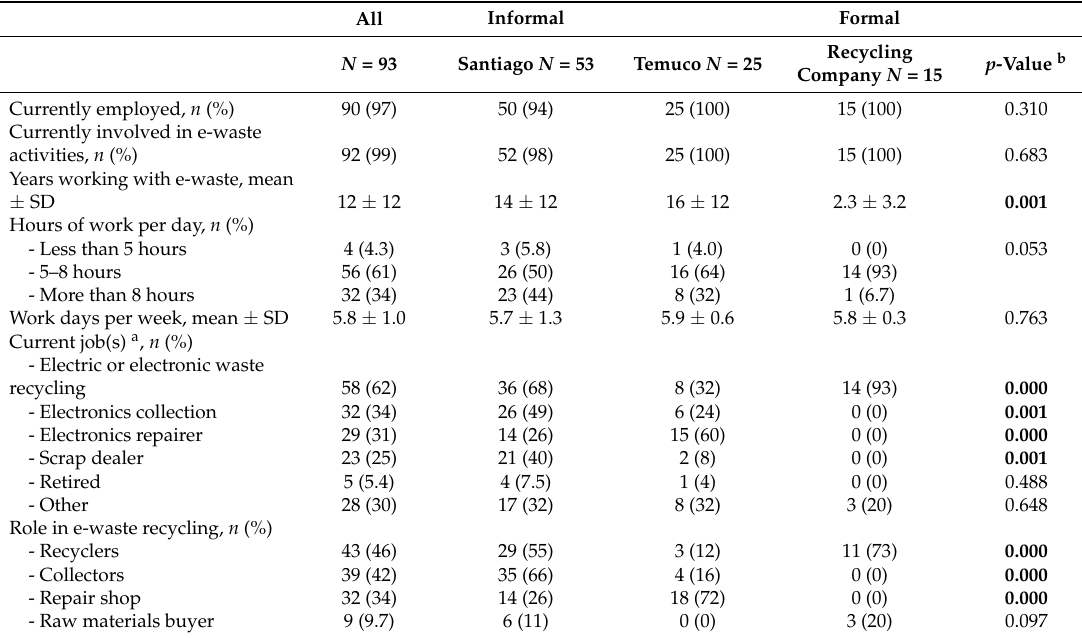
Table 3. Work history and recycling activities, by job type and